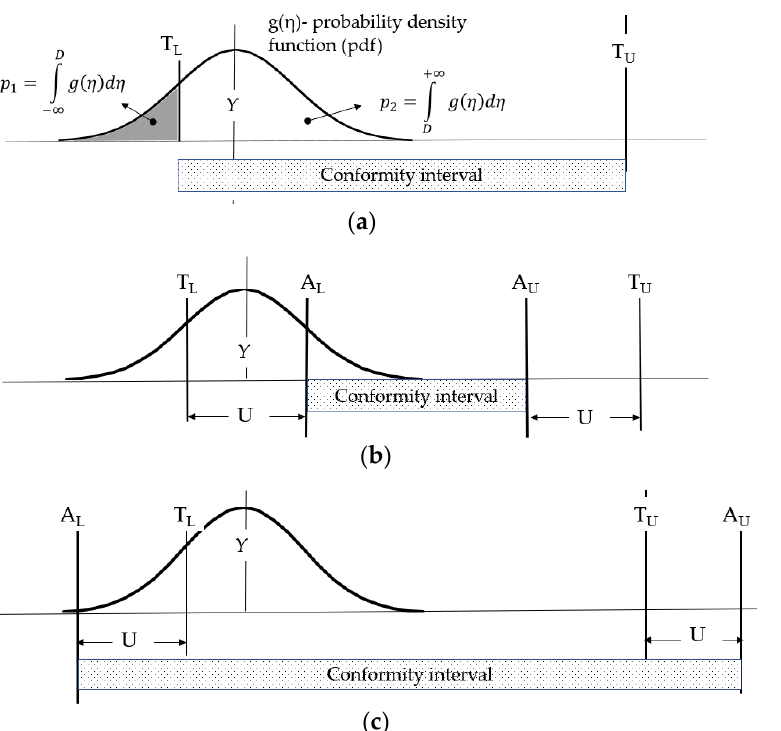
Figure 2. Diagram showing the difference between simple acceptance, guarded acceptance and guarded rejection. The symbols are explained in the text. ( a ) Simple acceptance rule diagram. Y 1 is considered compliant with the Y ≥ T L criterion. p 1 — the probability that the test result does not comply with the requirement. p 2 — the probability that the test result is compliant ( b ) Guarded acceptance diagram. A new criterion for guarded acceptance: Y ≥ A L . When this rule is applied, Y 1 is considered non-compliant. ( c ) Guarded rejection diagram. The criterion for guarded acceptance: Y ≥ A L .